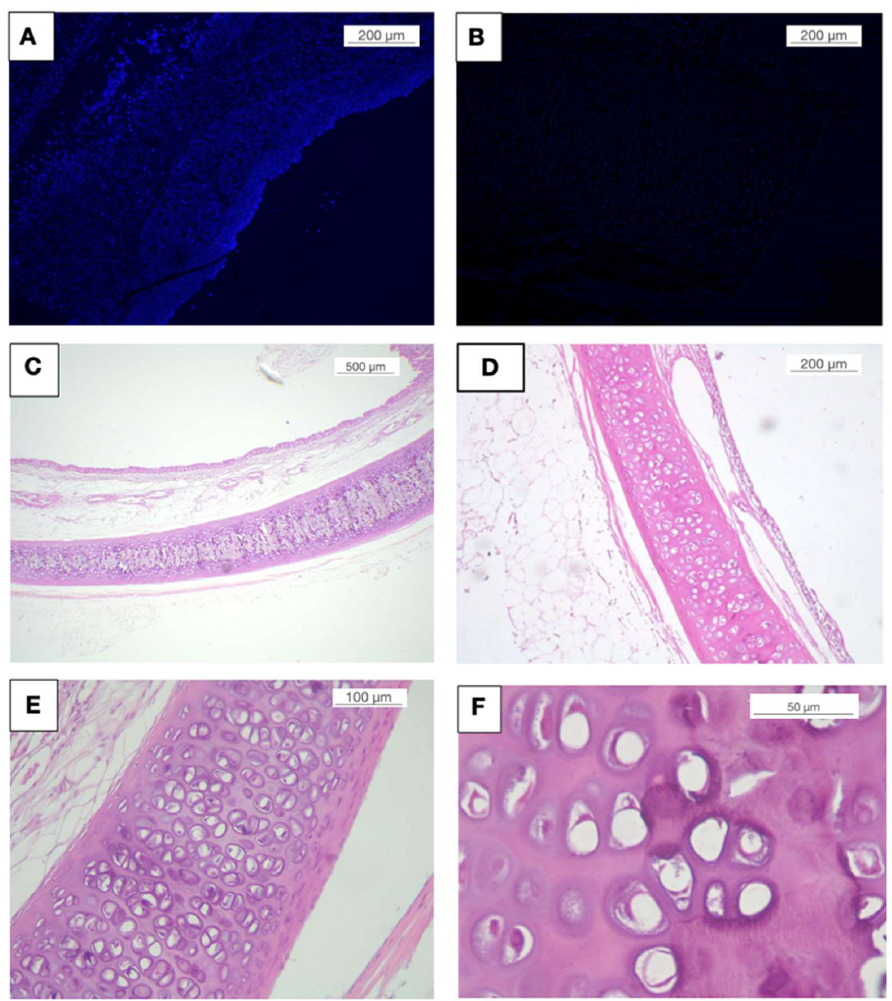
Figure 6. Histological analysis of decellularised tracheas. Fresh ( A , C , E ) and decellularised tra- cheas ( B , D , F ) were analyzed by DAPI ( A , B ) and by hematoxylin eosin ( C – F ). Cell removal in the decellularised tracheas was almost 100% compared to the fresh tracheas.